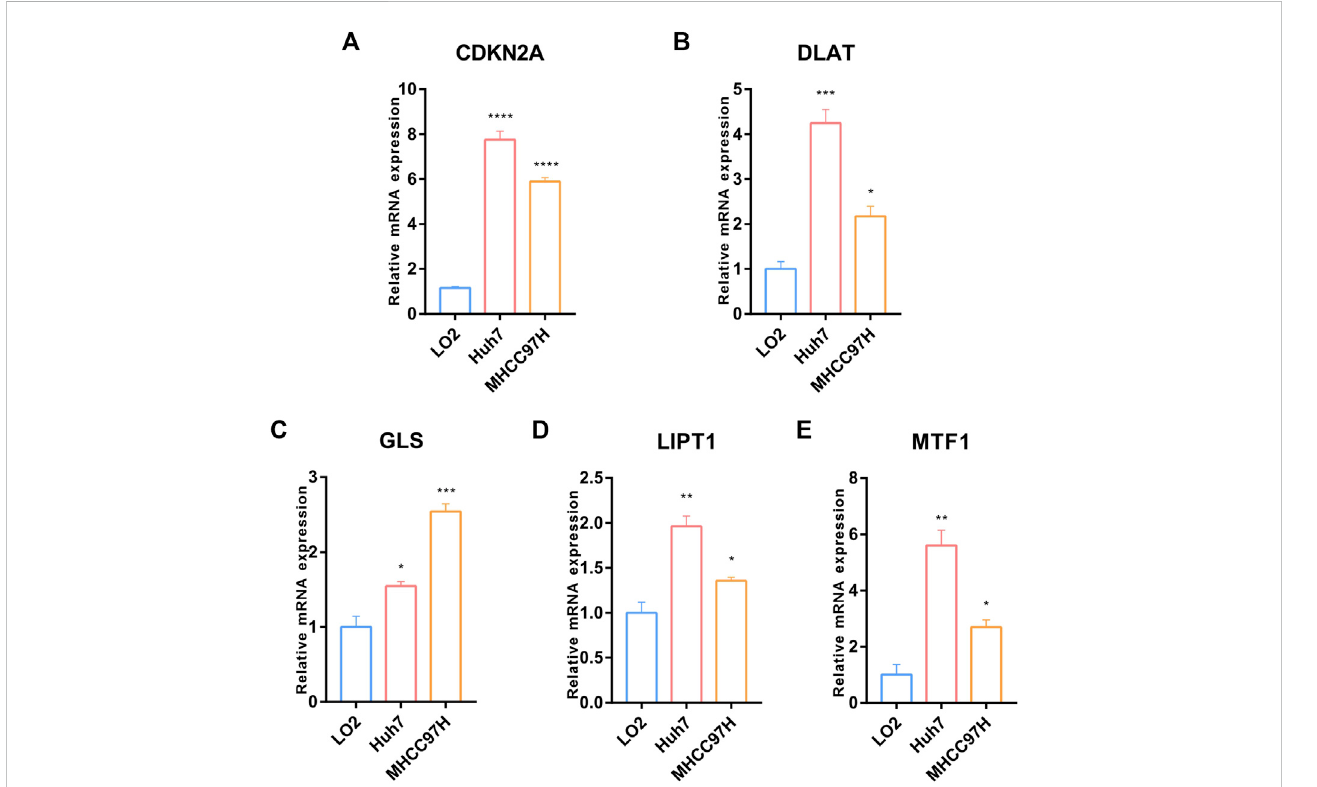
FIGURE 10 Validation of the expression of the fi ve prognostic CRGs in-vitro HCC cell lines model. (A – E) RT-qPCR was performed to detect the expression of CDKN2A, DLAT, GLS,LIPT1andMTF1 innormal livercell(LO2) andHCCcells(Huh7and MHCC97H) (Dataarepresentedasmean± SEM, t -test,* p < .05;** p < .01; *** p < .001; **** p < .0001; ns: not statistically signi fi